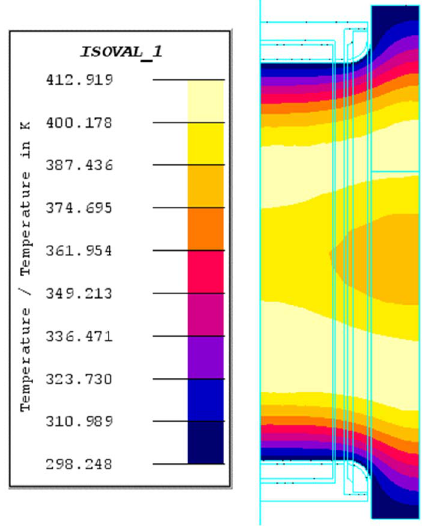
Figure 16. Temperature field of crankshaft N1 after liquid cooling.